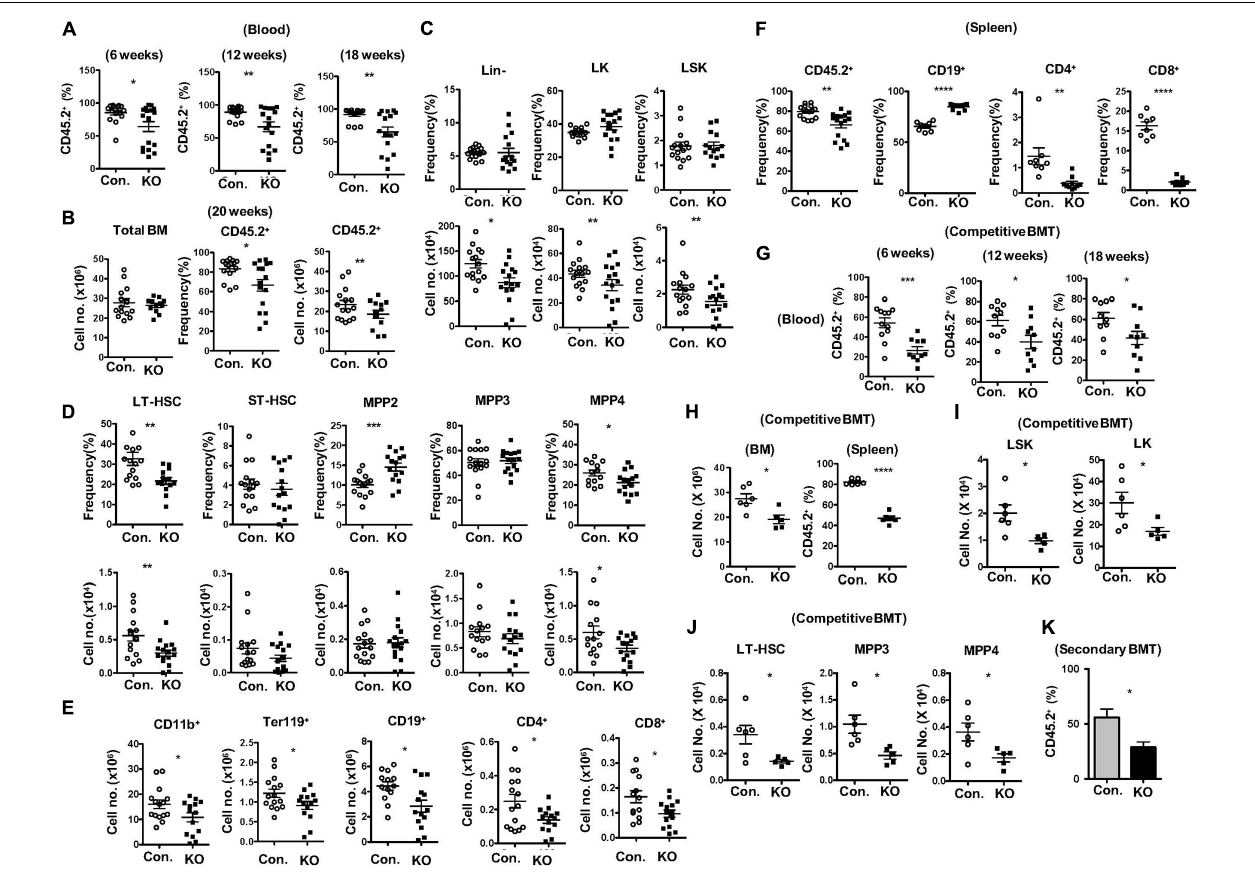
FIGURE 3 | Lack of Rbpj leads to compromised radiation stress induced HSC functions. (A) Frequencies of donor derived chimera (CD45.2 + ) in the peripheral blood of lethally irradiated congenic recipients that received total BM of either KO or control mice at 6, 12, and 18 weeks of transplantation. (B) Absolute cell number of total BM (left) and frequencies (middle) and absolute cell numbers (right) of donor derived chimera (CD45.2 + ) from KO and Control recipient mice ( n = 12–25) at 20 weeks of transplantation. (C,D) Frequencies (top) and absolute numbers (bottom) of Lin-, LK, LSK, LT-HSCs, ST-HSCs, MPP2, MPP3, and MPP4 subsets of BM (two femurs and two tibias) from KO and Control recipient mice ( n = 12–15) at 20 weeks of transplantation. (E) Frequencies of donor derived (CD45.2 + ) CD11b + , Ter119 + , CD19 + , CD4 + , and CD8 + cells in the BM (two femurs and two tibias) from KO and Control recipient mice ( n = 10–13) at 20 weeks of transplantation. (F) Frequencies of donor derived (CD45.2 + ) splenocytes and CD19 + , CD4 + , and CD8 + subsets in the spleen from KO and Control recipient mice ( n = 8–12) at 20 weeks of transplantation. (G) Frequencies of KO and Control derived (CD45.2 + ) chimera in the peripheral blood of lethally irradiated congenic recipients that received mixed BM of either KO or control + competitor (1:1) at 6, 12, and 18 weeks of transplantation. (H) CD45.2 + KO and Control derived cell counts in the BM and frequencies in the spleen of recipients ( n = 6) that received mixed BM of either KO or control + competitor (1:1) at 20 weeks of transplantation. (I,J) Absolute numbers of KO and control (CD45.2 + ) derived LK, LSK, LT-HSC, MPP3, and MPP4 subsets in the BM of recipients ( n = 6) that received mixed BM of either KO or control + competitor (1:1) at 20 weeks of transplantation. (K) Frequencies of donor derived (CD45.2 + ) chimera in the peripheral blood of secondary recipients that received total BM of primary recipients from (G) at 8 weeks of secondary transplantation. All data represent mean ± SEM. Two-tailed Student’s t- tests were used to assess statistical significance (* P < 0.05; ** P < 0.01; *** P < 0.001; **** P <